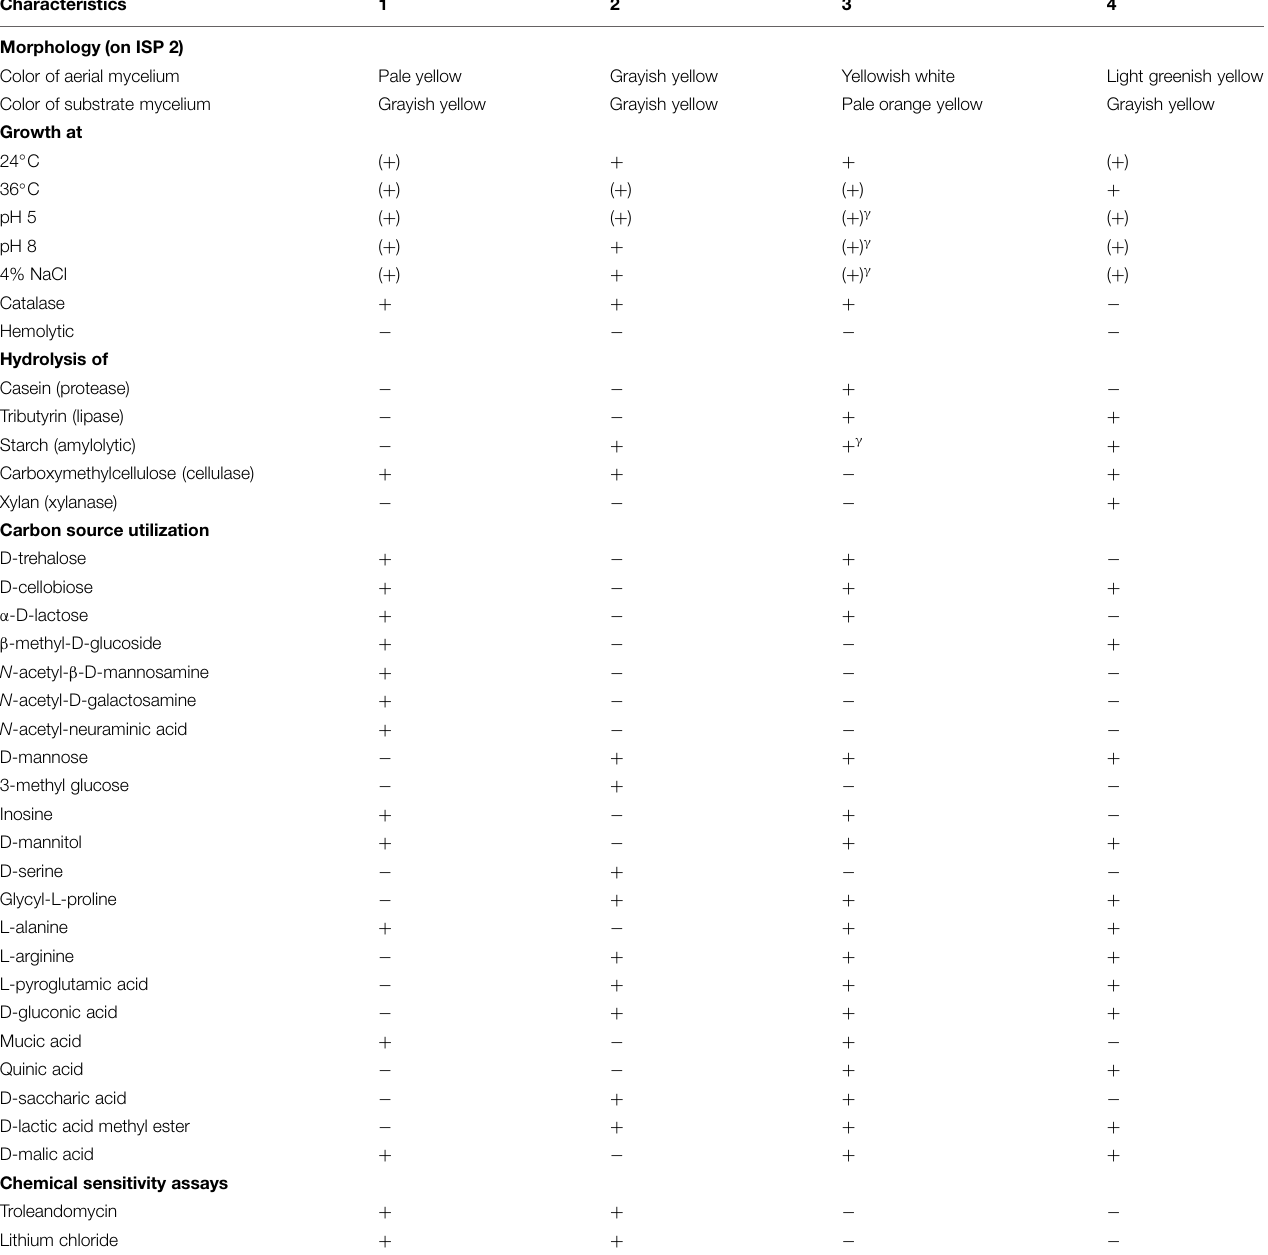
TABLE 1 | Differentiation characteristics of strain MUSC 149 T and type strains of phylogenetically closely related species of the genus Streptomyces . Characteristics